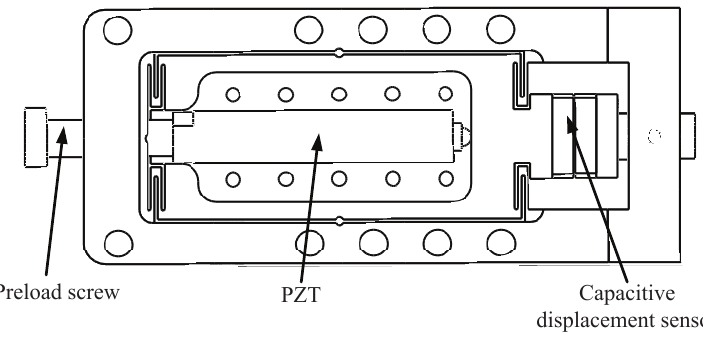
Figure 2. Structure of the micropositioning stage.